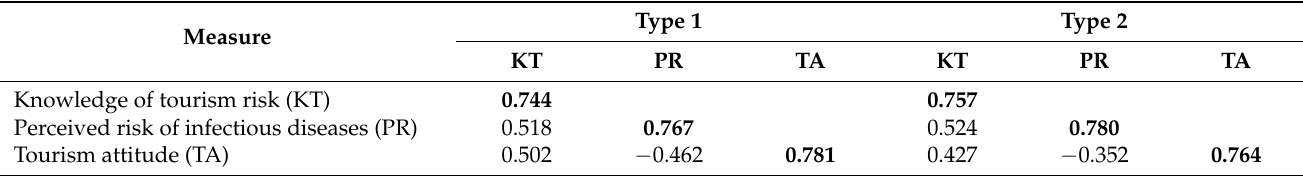
Table 4. Discriminant validity analysis based on the Fornell–Larcker